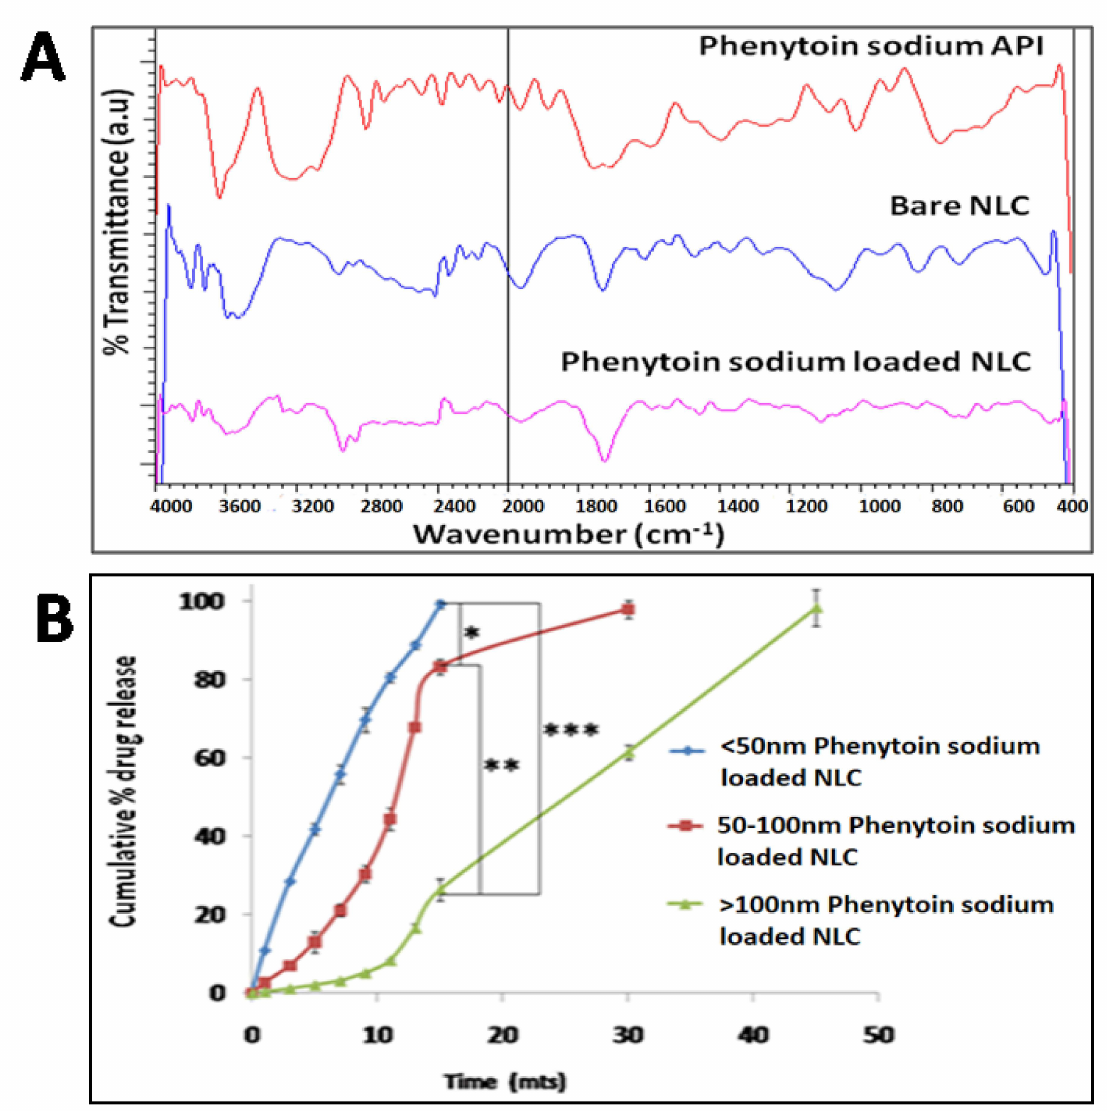
Figure 3. Characterization of NLC by FTIR analysis ( A ). In vitro drug release study of phenytoin sodium NLCs ( B ). The level of statistical significance is expressed as a p -value; * indicates p < 0.05, ** indicates p < 0.01, *** indicates p <